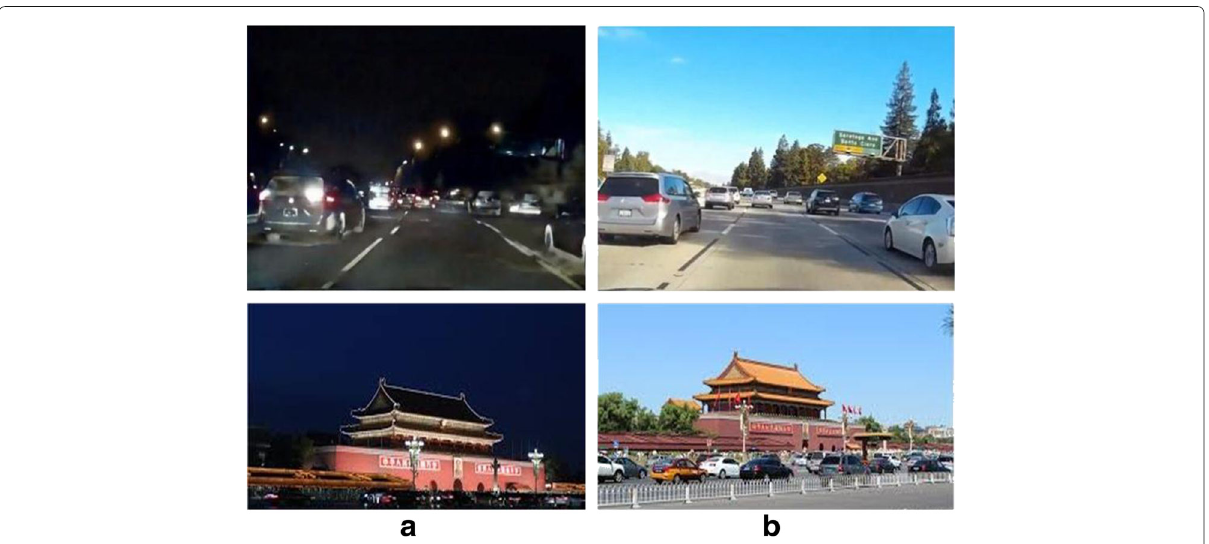
Fig. 1 Images captured in nighttime low illumination and daytime. a Images captured in nighttime. b Images captured in daytime